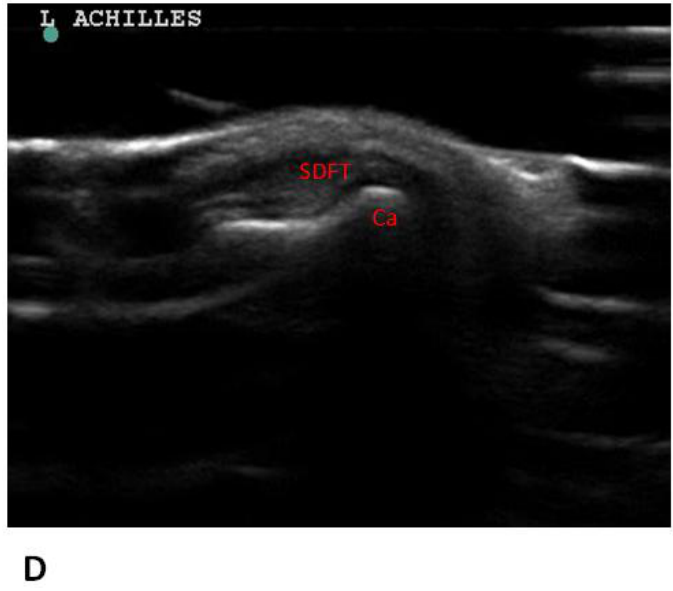
Figure 6D : Cross-sectional view of the SDFT Visualization of the SDFT as it courses over the calcaneal tuberosity